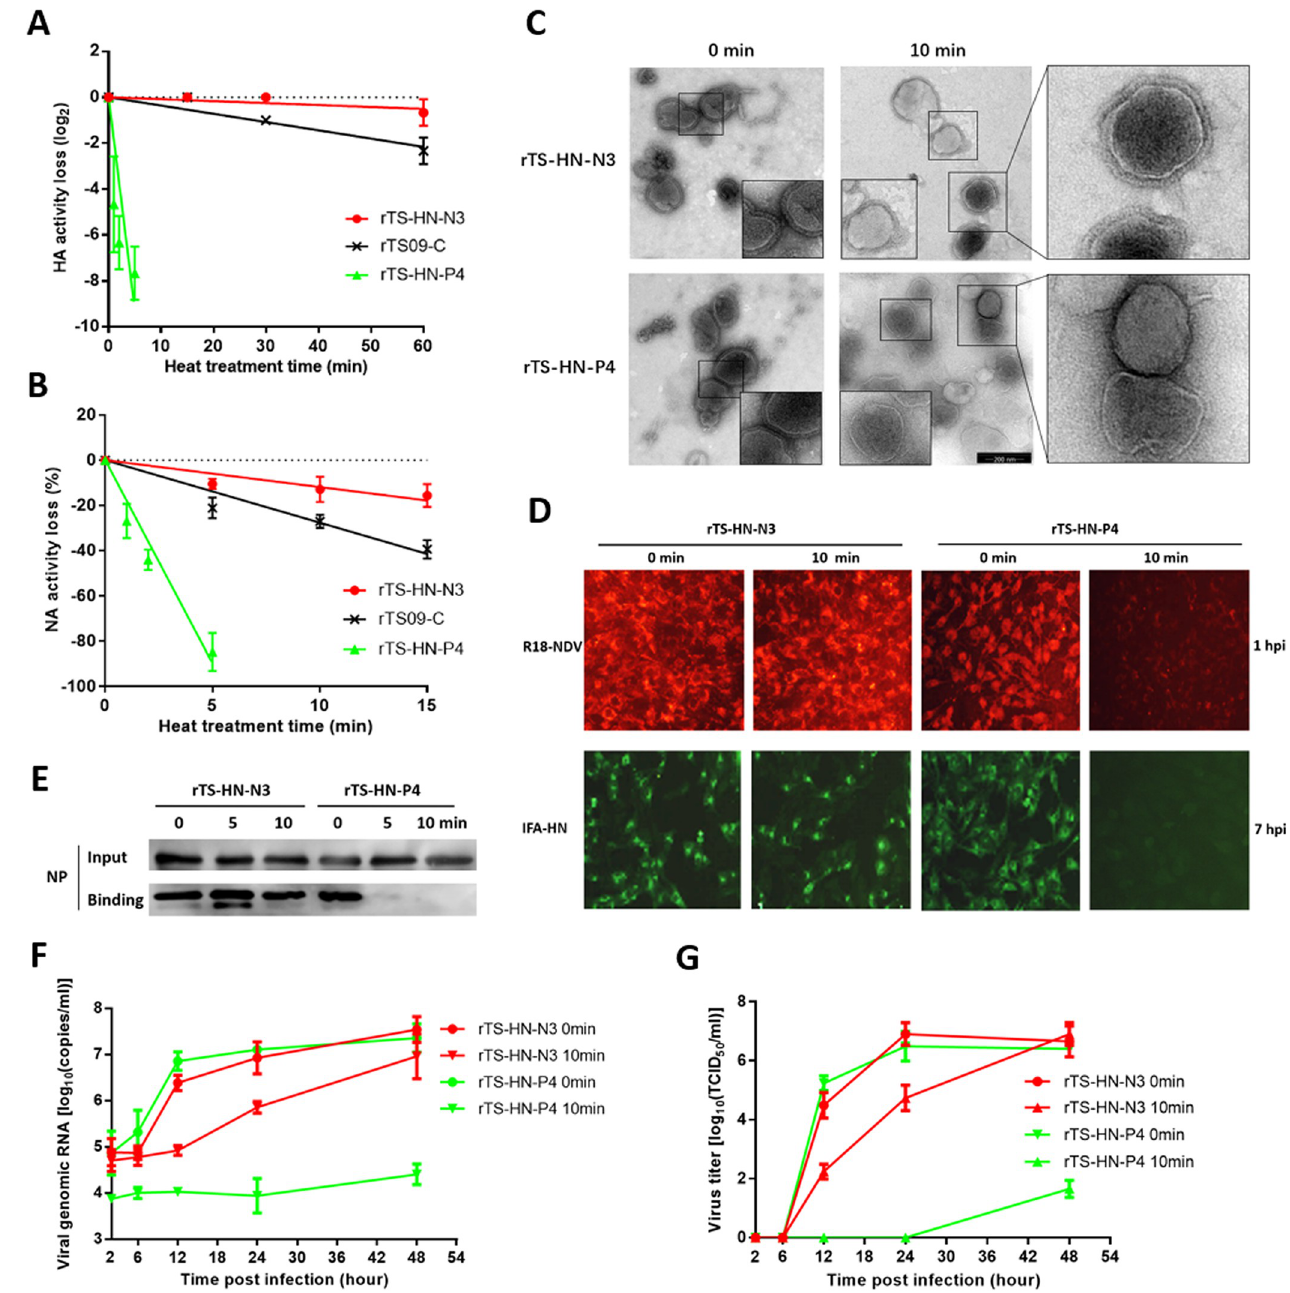
Fig 3. Effect of the surface charge of HN proteins on the cell-binding stability of NDV. Heat-inactivation kinetics of HA activity (A) and NA activity (B) of the NDV mutants are determined at 56˚C. (C) Electron micrographs of heat-treated rNDVs. NDV mutants are heat-treated for 10 min at 56˚C, then negatively stained with phosphotungstic acid. (D) R18-labeled NDV mutants are heat-treated for 10 min at 56˚C, then inoculated into BHK-21 cells (moi 50) at 37˚C. At 1 hpi, cells are directly observed using fluorescence microscopy. At 7 hpi, HN expression in BHK-21 cells is analyzed by IFA using rabbit serum against HN protein. (E) NDV mutants are heat-treated for the indicated times at 56˚C, then incubated with BHK-21 cells (moi 10) at 4˚C for 1 hour. The lysates of cells bound with NDV and equal volumes of the virus input are resolved by SDS-PAGE. Western blot is performed with rabbit serum against NP protein. (F) BHK- 21 cells are infected with NDV mutants heat-treated for 10 min at 56˚C (moi 1.0). Cells are harvested and lysed at the indicated time points, then analyzed for the replication level of NDV genomic RNA by using a real-time RT-PCR assay. (G) BHK-21 cells are infected with NDV mutants heat-treated for 10 min at 56˚C (moi 1.0). Media from infected cells are harvested at the indicated time points and virus titers are determined by TCID 50 titration in BHK-21 cells.